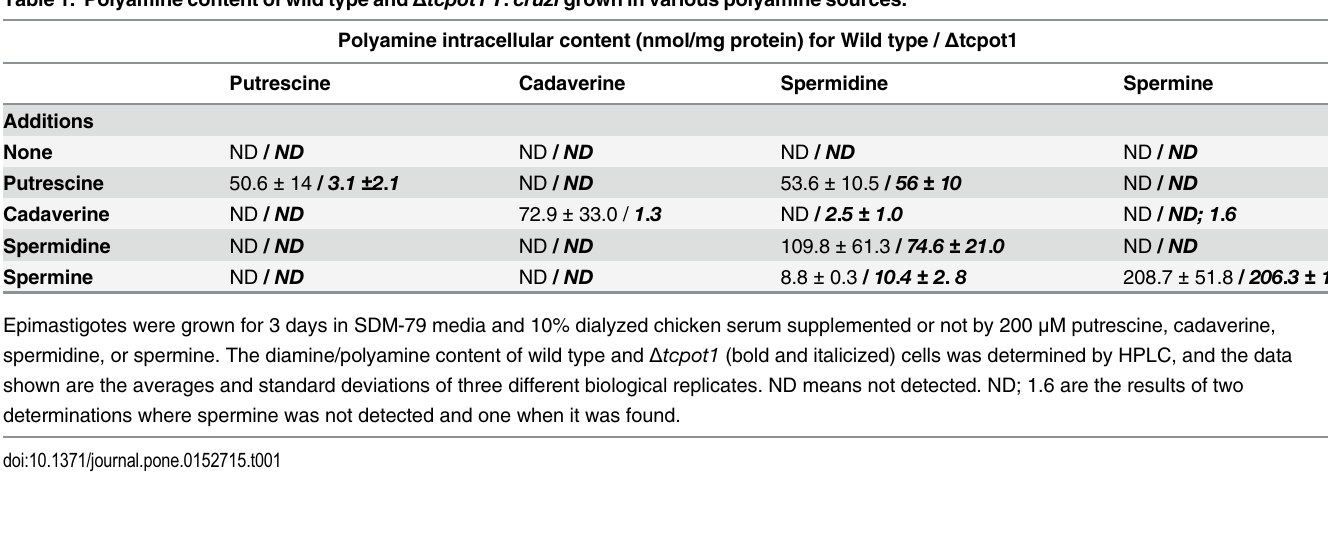
Table 1. Polyamine content of wild type and Δ tcpot1 T . cruzi grown in various polyamine